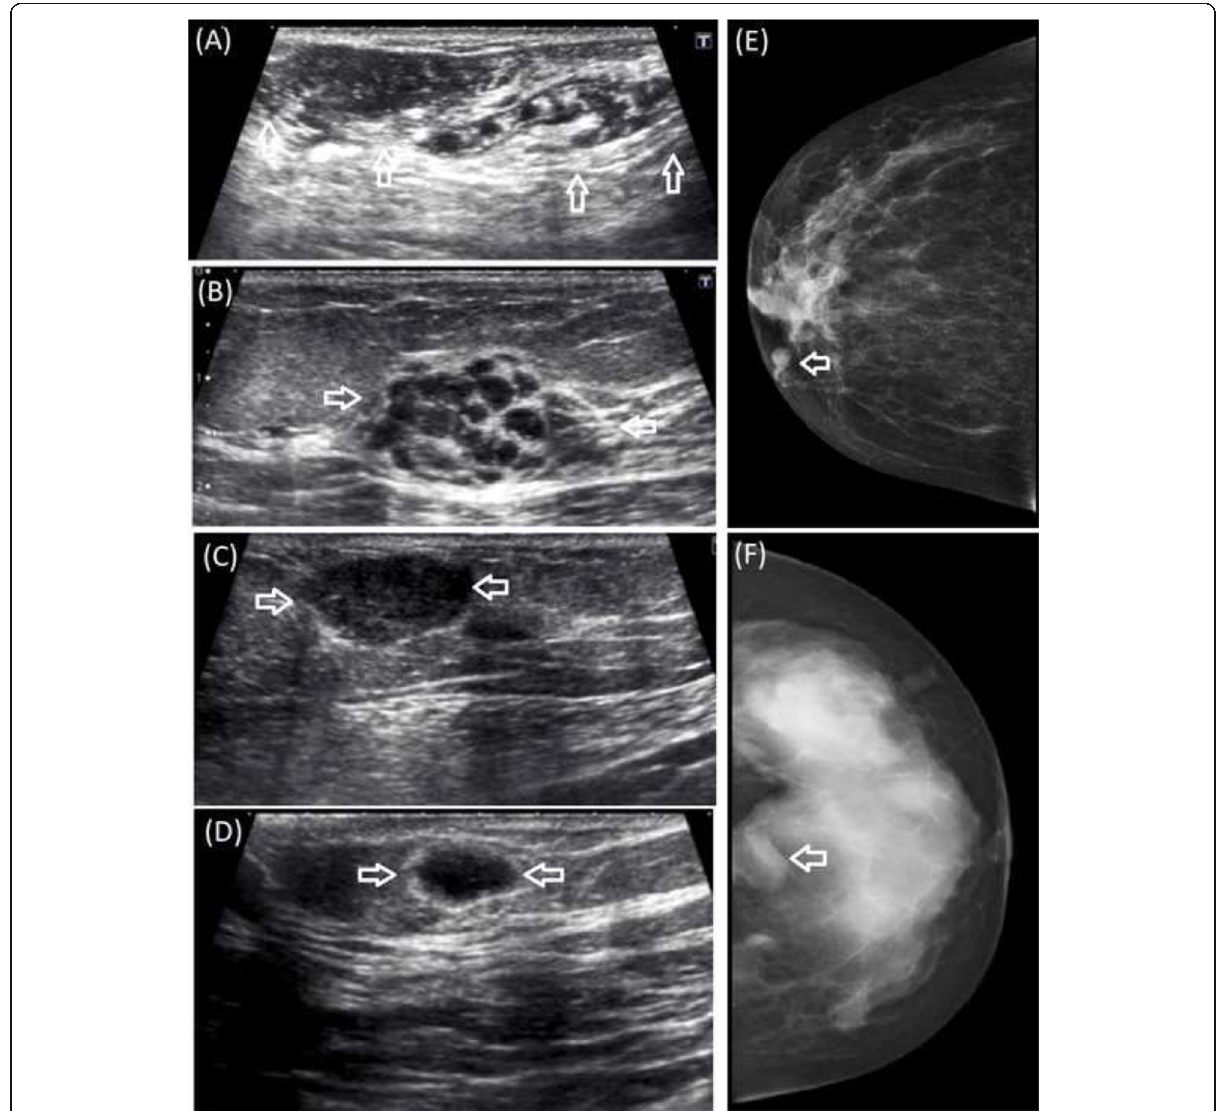
Fig. 1 Hematological malignancies mimicking benign breast lesions. US images ( a – d ) and mammography views ( e , f ) of granulocytic sarcoma ( a , b , f ), lymphoma ( c ), and plasmacytoma ( d , e ) showing oval-shaped, circumscribed lesions. Posterior shadowing is not seen on US images and microcalcifications are not observed on mammography images. Hyperechoic areas can resemble hamartoma ( a , b ) and fibroadenoma ( c , d )